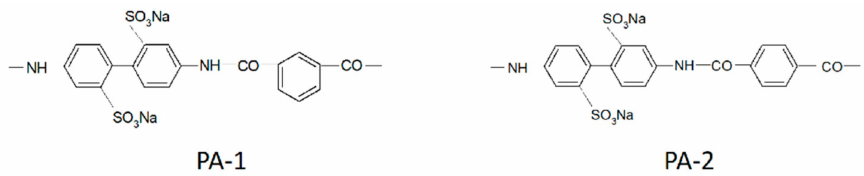
Figure 48. Chemical structure of sulfocontaining aromatic polyamides PA-1 and